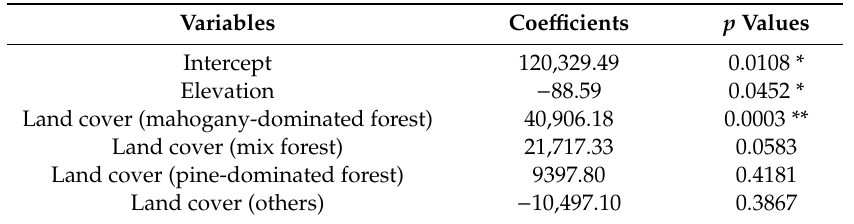
Table 4. Summary of the results of regression